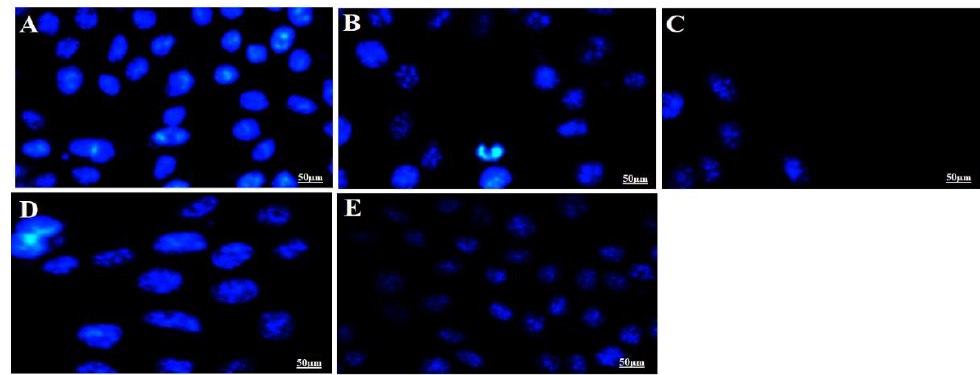
Figure 7. In vitro apoptotic assay carried out for different treated time (12 h and 24 h) to visualize the nuclear morphological changes of apoptotic cells post treatment with F11 (5.27 µg/mL) and 5-FU pure drug (22.25 µg/mL) at their IC 50 concentration. Fluorescence microscopic images revealed stained MCF-7 nucleus with Hoechst 33342 dye based on their morphological variation at varied time points.